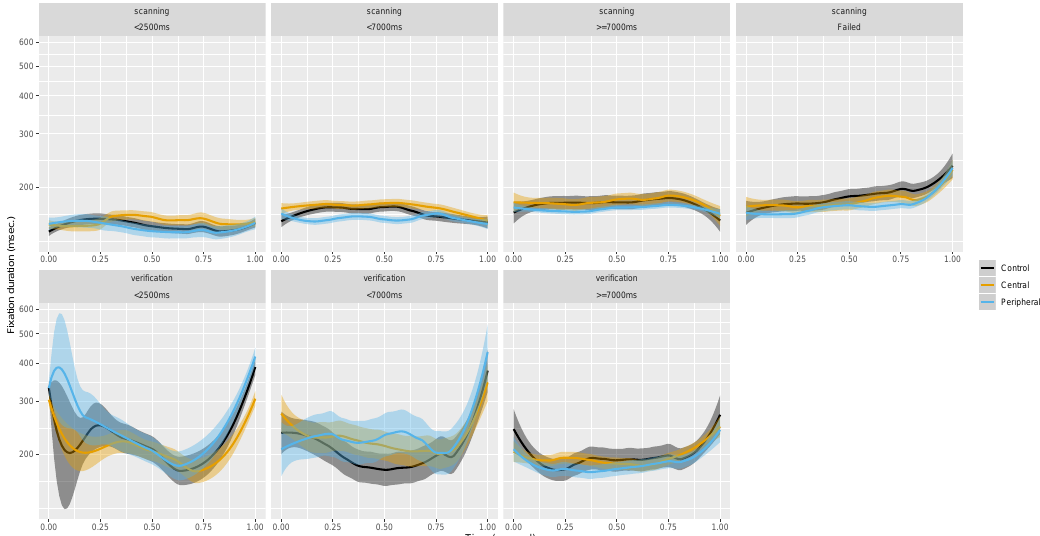
Figure A6. Time-course of average fixation duration during saccades as a function of phase search (trial duration subgroups do not overlap). Ribbons show 95%CI. Control condition appears in black, central in orange and peripheral in